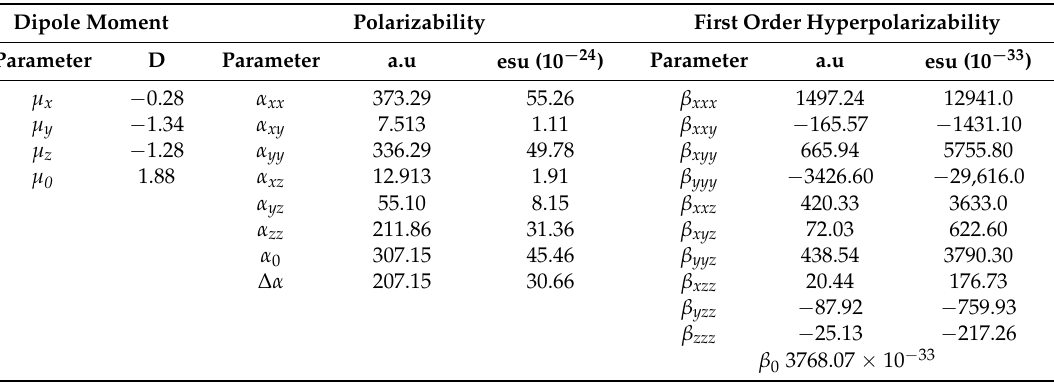
Table 8. Electrical dipole moment, polarizability and first order hyperpolarizability of 4c at the level DFT/B3LYP/6-31G(d,p).